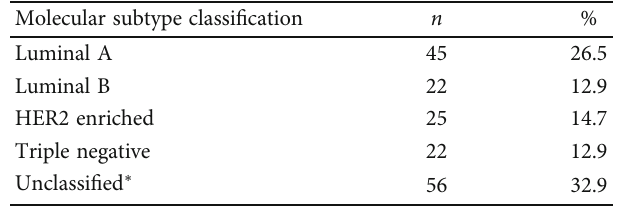
Table 6: Prevalence of di ff erent breast cancer molecular subtypes ( n = 170